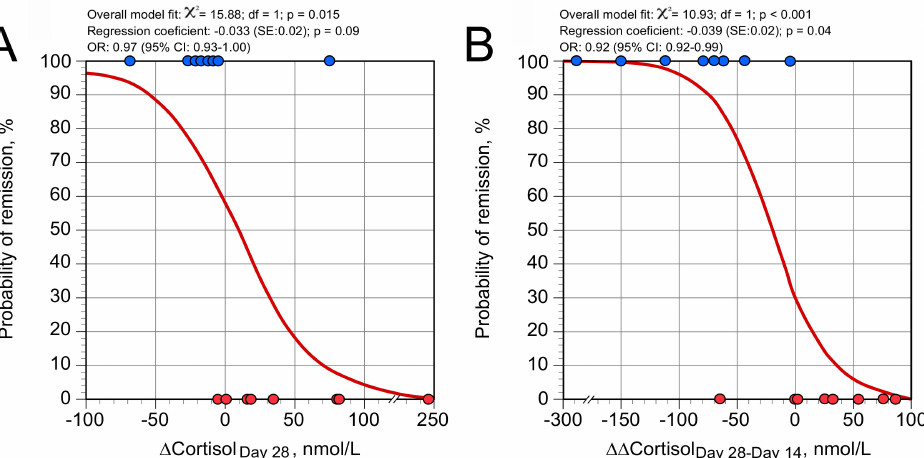
Figure 3. Predicted probability of remission/non-remission (on Day 42) based on ( A ) ∆ COR Day 28 values after 4 weeks of antidepressant treatment (ADT), and ( B ) ∆∆ COR Day 28–Day 14 (difference between ∆ COR values after 4 and 2 weeks of ADT) using a logistic regression prediction curve. Logistic regression produces the regression coefficient (and standard errors (SEs) of estimate, and significance level) and odds ratio (OR, with 95% confidence interval) associated with each ∆ COR ∆∆ COR Day 28 or Day 28–Day 14